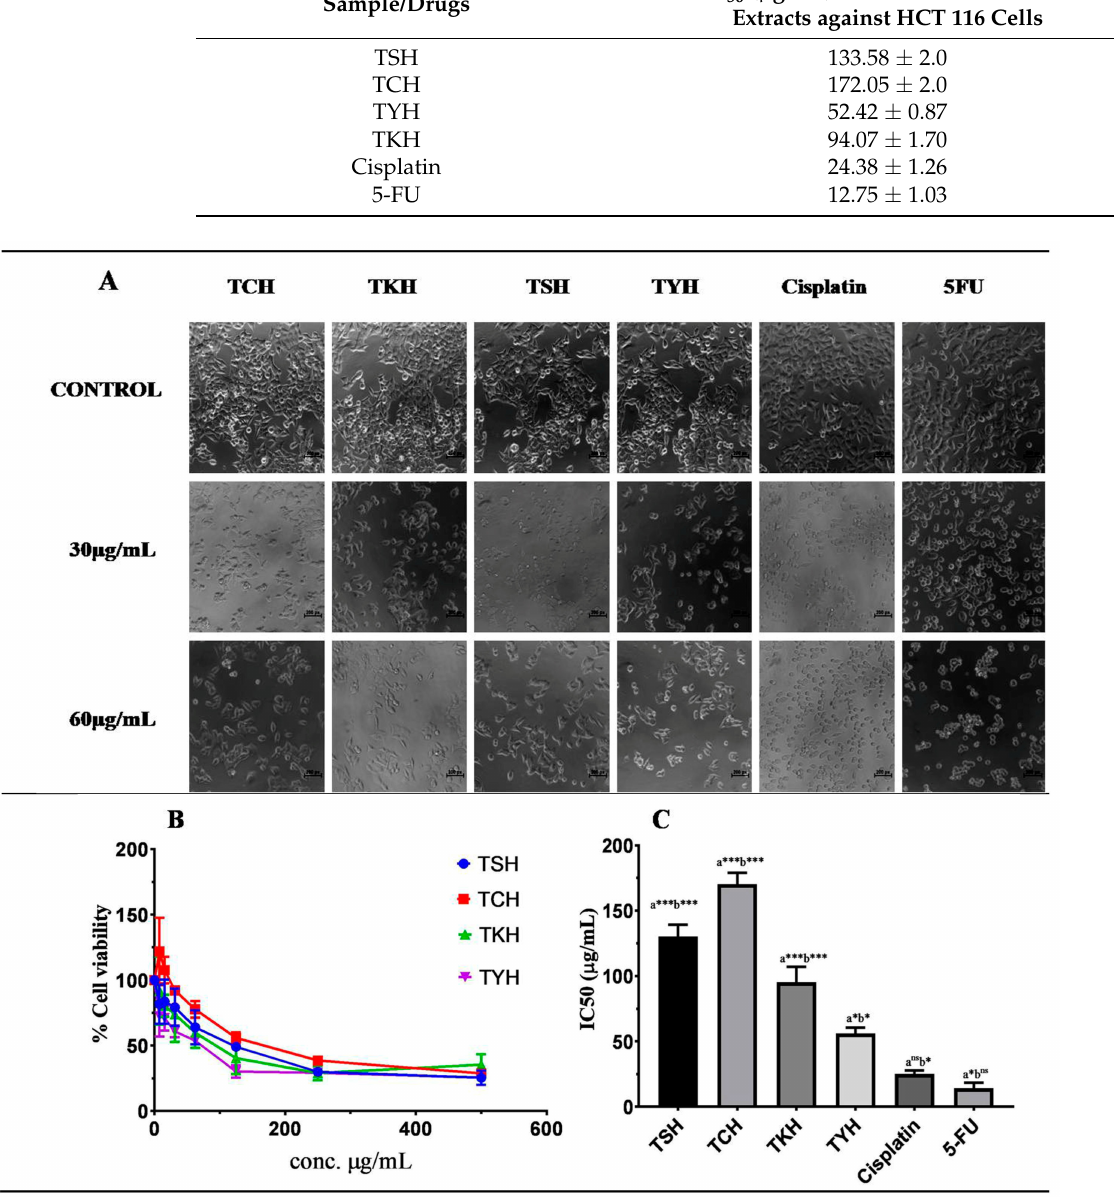
Figure 3. ( A ) Morphology of cells as observed, under inverted light microscope, after treatment with varying concentrations (0, 30, and 60 µ g/mL) of T. chebula extracts for 48 h. ( B ) Cytotoxic effect of T. chebula extracts on HCT116 cells was determined using MTT assay. Cells were seeded in 96-well plates and treated with varying concentrations (0–500 µ g/mL) of extracts. MTT assay was performed after 48 h. ( C ) Graphical representation of IC 50 values of T. chebula extracts and standard drugs cisplatin and 5-FU. One-way ANOVA; p < 0.05; n = 3 (*** p < 0.001; * p < 0.05) (“a”, comparison with cisplatin; “b”, comparison with